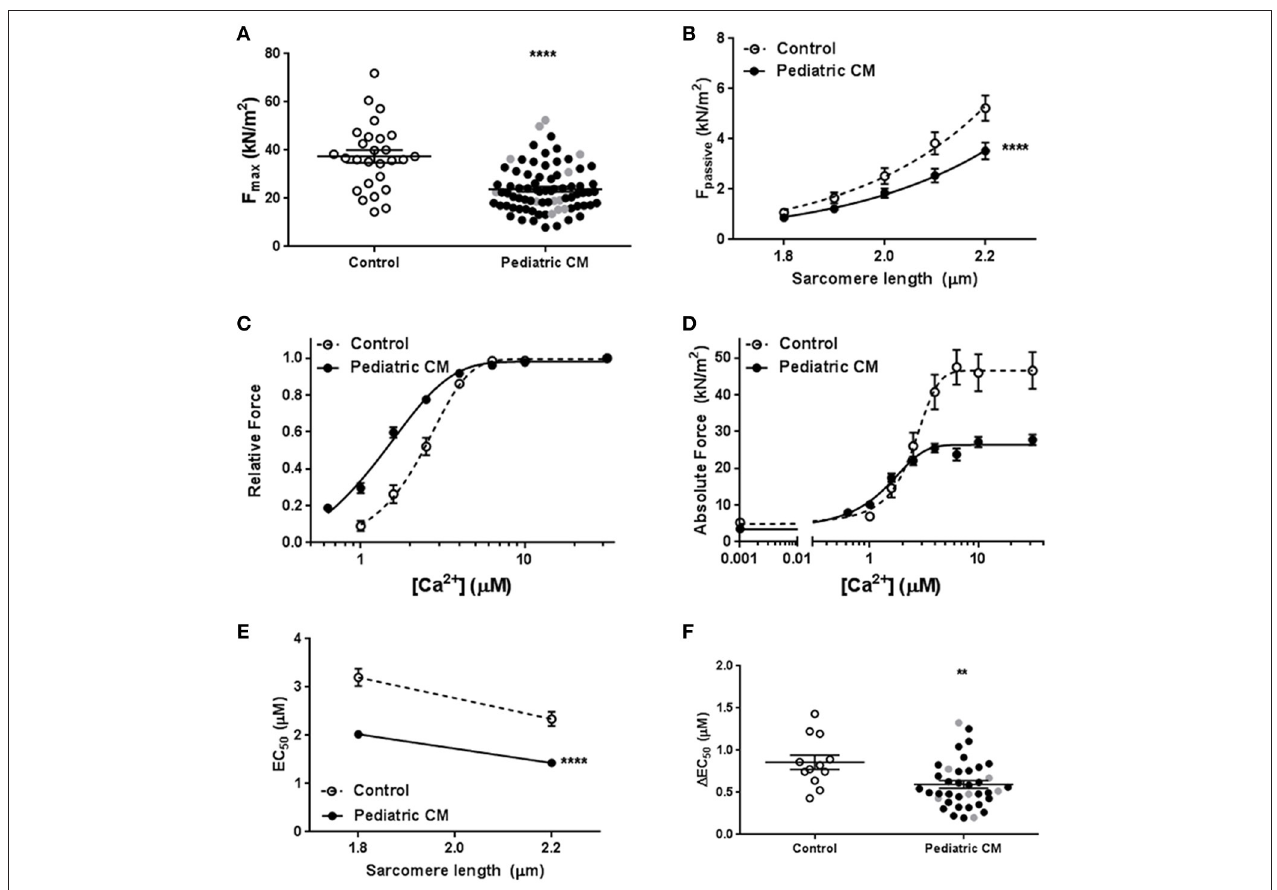
FIGURE 1 | Baseline characteristics. (A) Maximal force was significantly lower in pediatric CM (23.8 ± 1.1, N = 11, n = 78) compared to controls (37.4 ± 2.6, N = 6, n = 27, p < 0.0001). (B) F pass was significantly lower in pediatric CM ( N = 11, n = 40) compared to controls ( N = 10, n = 29, p < 0.0001) over a range of sarcomere lengths. (C) A leftward shift of the relative force vs. [Ca 2 + ] indicates higher myofilament Ca 2 + -sensitivity in pediatric CM ( N = 11, n = 38) compared to controls ( N = 5, n = 12, p < 0.0001). (D) The absolute force development over a range of [Ca 2 + ] showed pediatric CM have impaired maximal force development at saturating [Ca 2 + ], increased force development at lower [Ca 2 + ] and a decreased F pass. (E) Ca 2 + -sensitivity was significantly higher at sarcomere lengths of 1.8 and 2.2 µ m in pediatric CM ( N = 11, n = 38) compared to controls ( N = 5, n = 12, p < 0.0001). (F) Length-dependent activation, measured as 1 EC 50 was significantly lower in pediatric CM (0.60 ± 0.05, N = 11, n = 38) compared to controls (0.86 ± 0.09, N = 5, n = 12, p = 0.007). N , number of samples; n , number of cardiomyocytes measured. Measurements obtained from samples derived from patients with non-compaction cardiomyopathy are indicated in gray (A,F) . ** p < 0.01, **** p < 0.0001 vs.